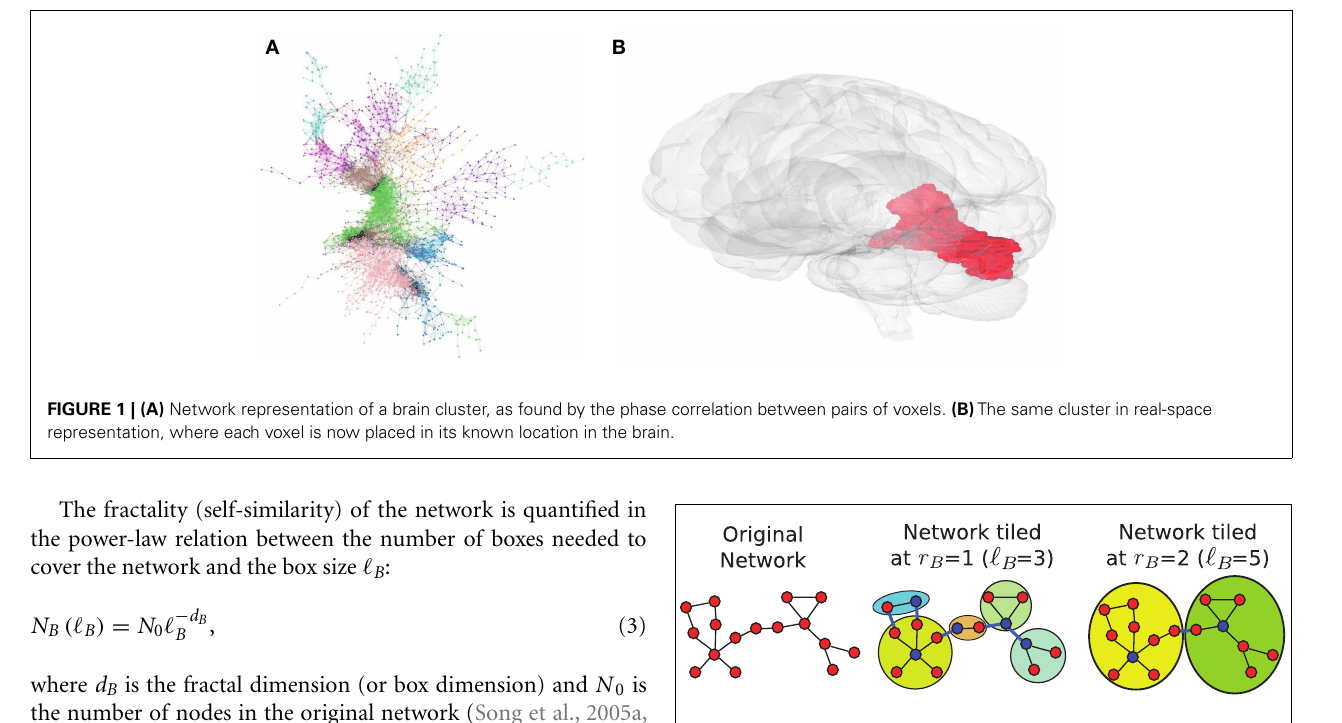
FIGURE 2 | Demonstration of the MEMB box-covering algorithm. For a given radius value, e.g., r B = 1 in the center panel and r B = 2 in the right panel, we cover the network with the smallest possible number of boxes. The diameter of the box, (cid:3) B (i.e., the distance between any two nodes in a box) is defined as (cid:3) B = 2 r B + 1. First, we detect the smallest possible number of box origins (shown with blue color) that provide the maximum number of nodes (mass) in each box, according to an optimization algorithm described in Song et al. (2007).Then, we build the boxes through simultaneous burning from these center nodes, until the entire network is covered with boxes. For the calculation of modularity, we consider the boxes at each r B value as separate modules.Then we calculate the ratio between the number of links within the modules (black links) and the number of links between modules (blue